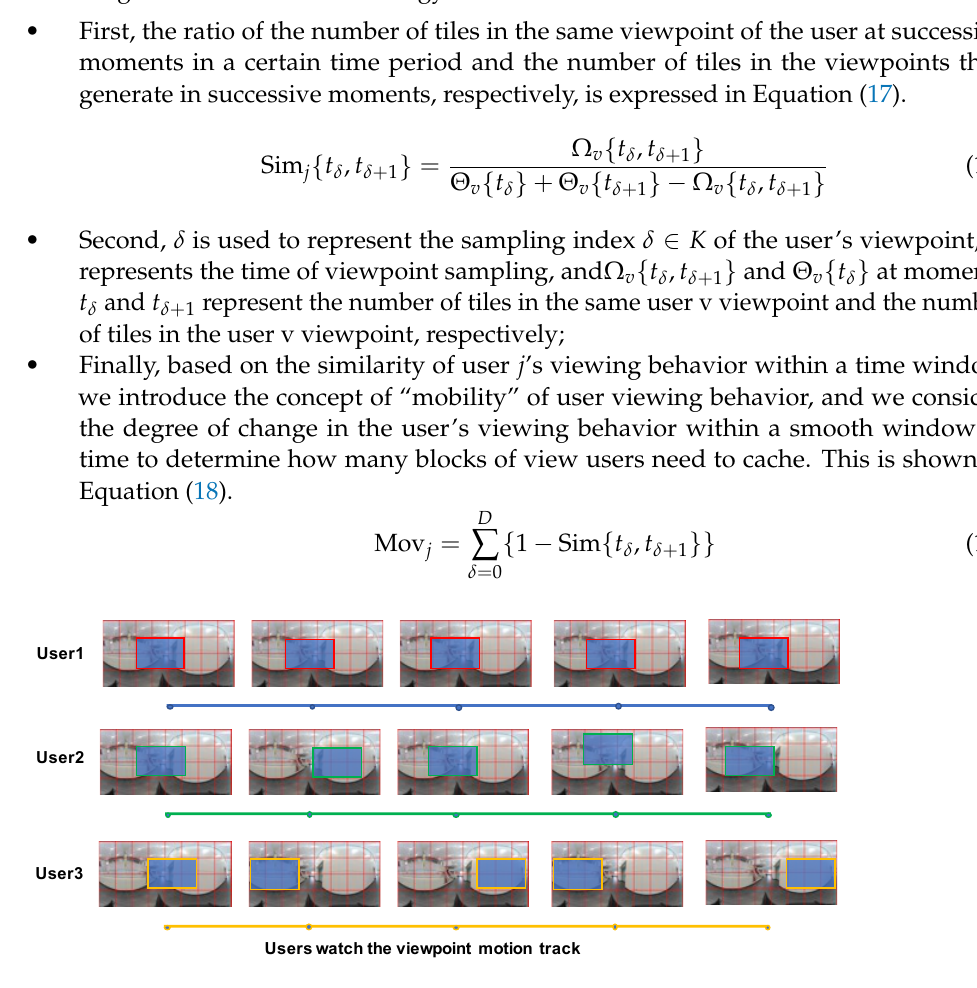
Figure 5. User viewpoint